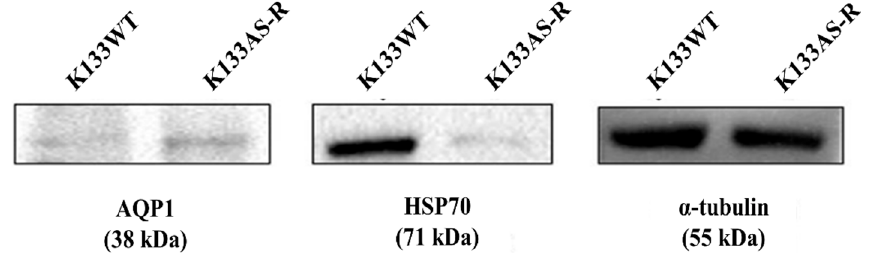
Figure 7. Expression analysis of AQP1 and HSP70 by Western blotting. Western blot analysis for the expression of AQP1 and HSP70 and α tubulin (endogenous control) protein was performed using 100 µ gpromastigote cell lysates of K133WT and K133AS-R parasites. Proteins separated on a 12% SDS–PAGE gel, transferred to nitrocellulose membranes that were probed with anti-AQP1, anti-HSP70, or anti- α tubulin antibody followed by horseradish peroxidase (HRP)-conjugated antibody and developed using enhanced chemiluminescence (ECL).